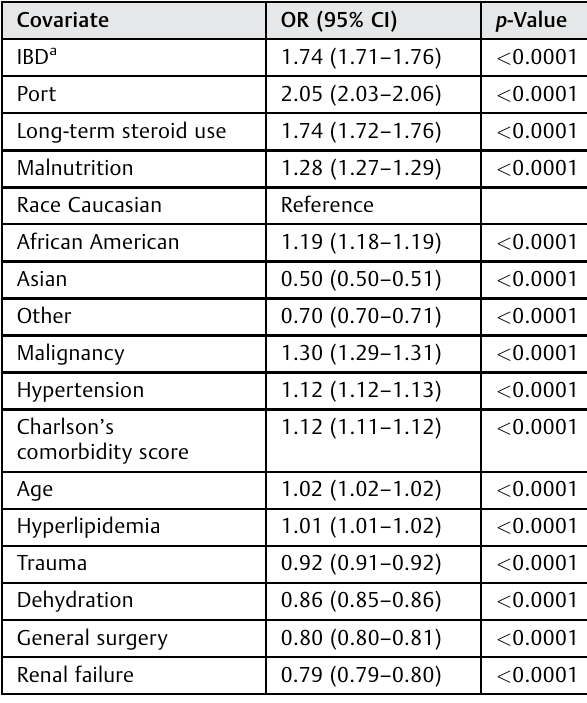
Table 4 Multivariable logistic regression odds ratios for thrombosis in all